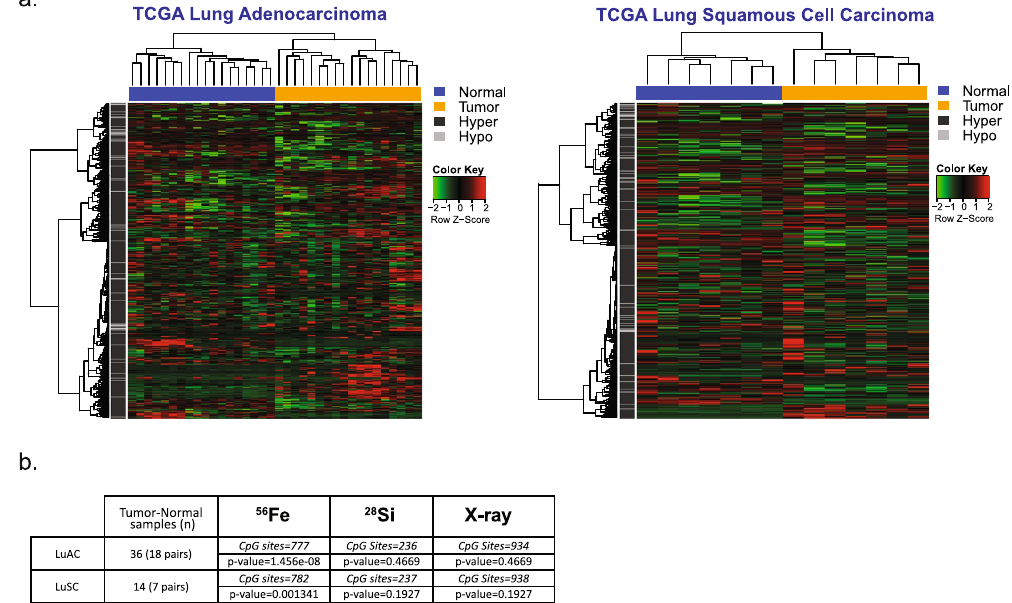
Figure 6. The 56 Fe-specific methylation ‘signature’ discriminates lung tumor from normal tissue in primary tissue samples. ( a ) DNA methylation status of the CpG sites significantly associated with Fe dose (n = 777) in normal bronchial epithelial cells was extracted for 25 lung tumor-normal pairs (18 adenocarcinomas, 7 squamous cell carcinomas) available in the TCGA project and used in unsupervised hierarchical cluster analysis (complete linkage, Manhattan distance metric). ( b ) An equivalent number of CpGs were chosen at random and used to group tissue samples using the same approach, and the process was repeated 1,000 times to estimate significance. The 56 Fe-sensitive CpGs outperformed any random set by several orders of magnitude. The methylation status of the 28 Si or the X ray affected sites had no significant association with tumor-specific differences in methylation (see